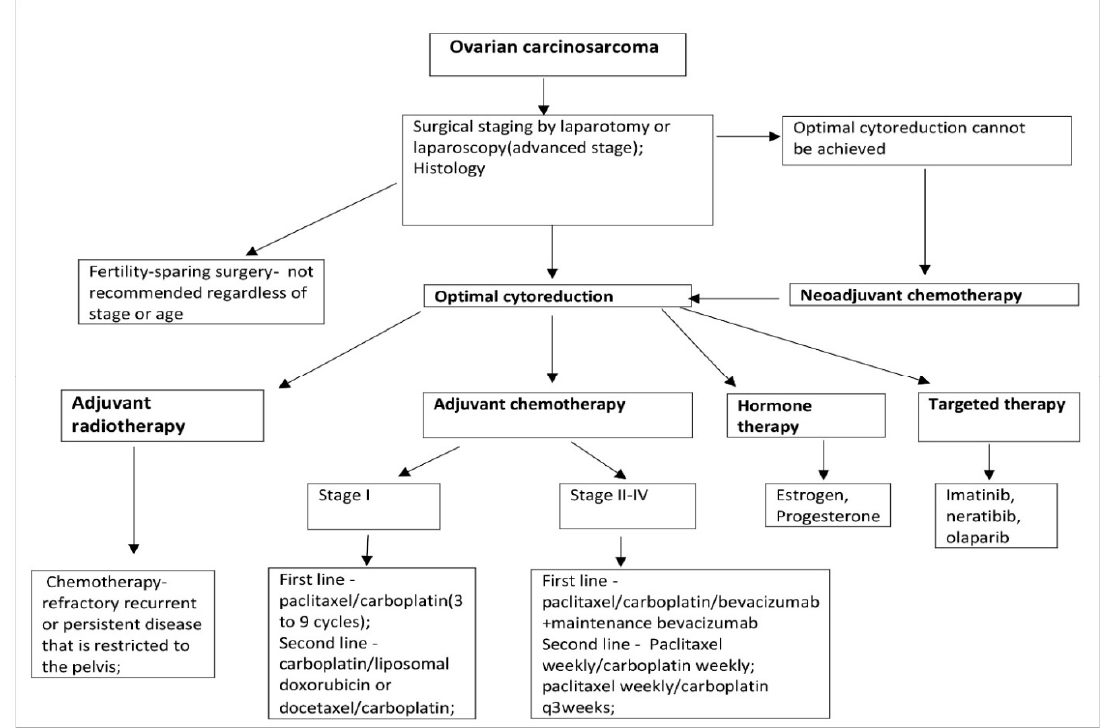
Fig.8 Ovarian carcinosarcoma treatment suggestion.